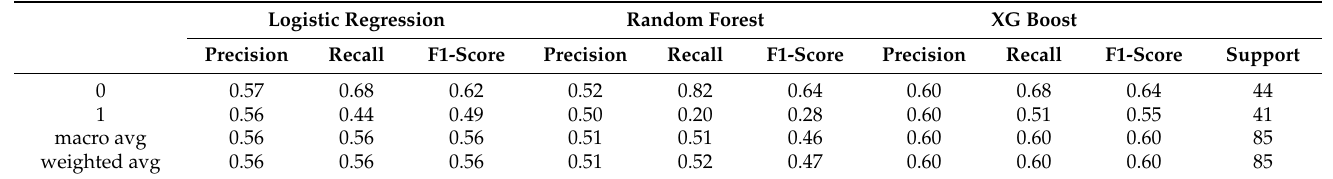
Table 6. Classification